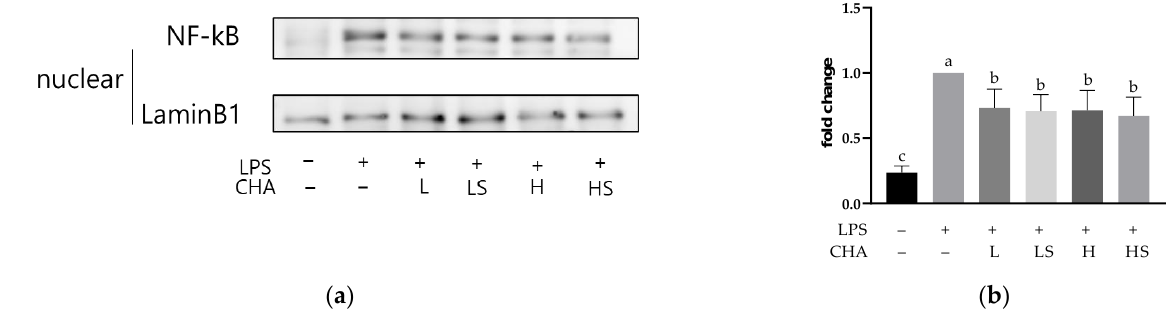
Figure 6. Effect of different delivery models on nuclear translocation of NF- κB. Cells were treated with LPS (100 ng/mL) and CHA for 2 h. ( a ) Representative images of NF- κB in the nuclear fraction. Lamin B1 was used as a loading control. ( b ) The protein expression level was quantified. Bars without a common letter indicate significant differences ( p < 0.05). CHA: chlorogenic acid; LPS: lipopolysaccharide; NF: nuclear factor; L: low dose administered via pipette; LS: low dose administered via syringe pump; H: high dose administered via pipette; HS: high dose administered via syringe pump.